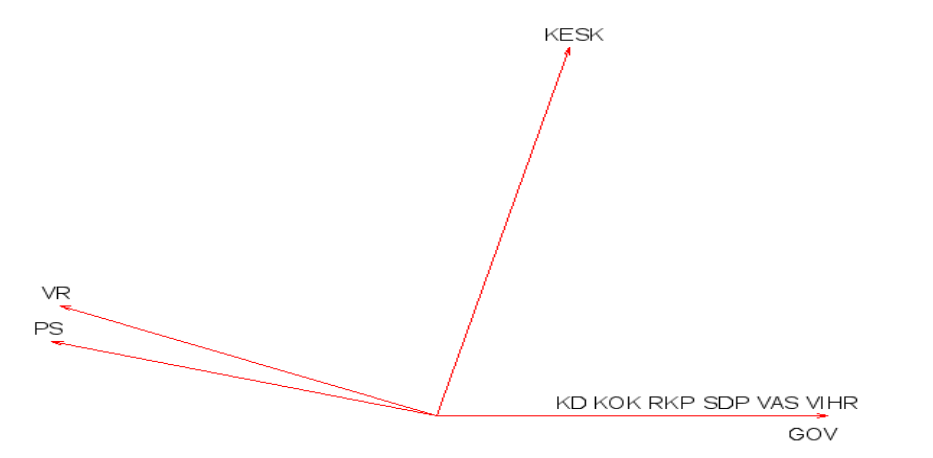
Figure 2f. Government and opposition voting during the first two years of the Katainen government